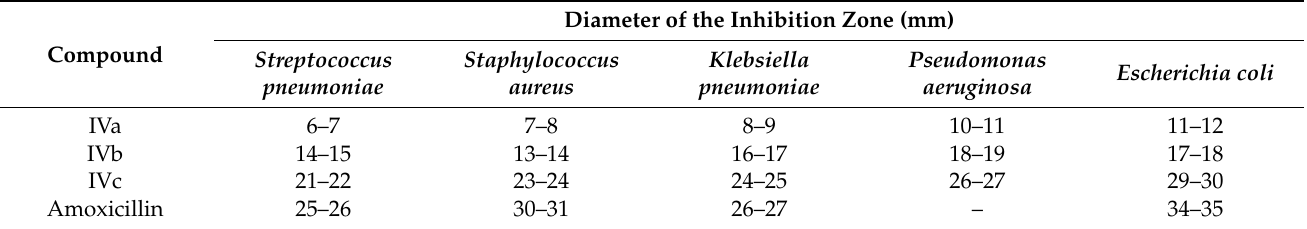
Table 6. Antimicrobial activity of the penicillins IVa–IVc and amoxicillin as reference